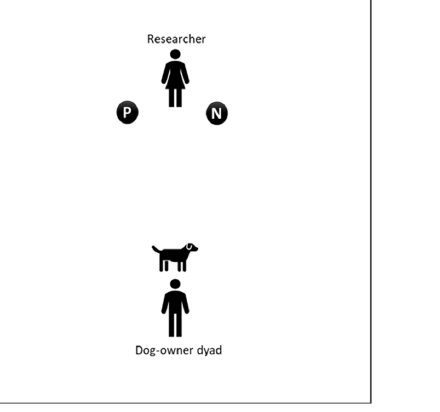
Figure 1. Room set up: The owner and the dogs were at one side of the room and the researcher was in a crouched position opposite to them. The circles in front of the experimenter mark the positions of the experimenter hands where they had a treat (P) or did not have a treat (N). Discrimination Learning. Dogs had to associate the presence (Positive) or absence (Negative) of food with the specific location (right or left). The food was placed in one hand of the experimenter, either the left or right hand. For 20 dogs, the positive location was on the left and the negative was on the right, while the opposite was true for the other half. To control for odor cues, both hands of the experimenter were equally smeared with food reward (sausage or ham) prior to testing. The experimenter stood approximately 1 m from the dog-owner dyad with hands closed and behind the body. To avoid pointing at the dog, the researcher avoided looking directly at the dog during the test. The owner held the dog to keep it in front of the experimenter (on a spot marked on the floor) and did not release the dog until the experimenter requested them to do it. At the beginning of each trial, the experimenter presented both hands closed and asked the owner to release the dog. The dog had to choose a hand, if he chose the positive hand, the experimenter opened it and gave the treat to the dog (the dog scored a point). If the dog approached the negative hand, the experimenter would not open it and would place both hands behind the body until the next trial (the dog scored no points). Each session consisted of ten trials. The dog was considered to have learned to associate the food with the positive position when it met the criteria of 9 out of 10 correct choices (9 points out of 10) in a single session or 8 out of 10 correct choices (8 points out of 10) in two sessions, consecutively. The maximum number of sessions was 5. Reversal learning. This task was identical to the discrimination learning task, except that the P and N were reversed. For example, if the positive stimulus was on the left, now it will be on the right. The duration of the complete test was 10 min, approximately. 2.3. Statistical Analysis SAS package (version 9.4, SAS Inst. Inc., Cary, NC, USA) was used for all statistical analysis. The total behavioral obtained from each of the 100 dogs evaluated with the CCAS was calculated by summing the scores obtained in each question. Questions belonging to the section Disorientation were summed twice. A Wilcoxon signed rank test was used to investigate whether there were significant differences between the scores obtained by each category of the CCAS. Multiple regression models by means of the GLM procedure were performed to de- velop prediction equations on a subsample of 40 dogs, which performed both CCAS and PCT. A first model was used to analyze the influence of the age of the dog, the gender and reproductive status on the score obtained by the CCAS. A second model was used to